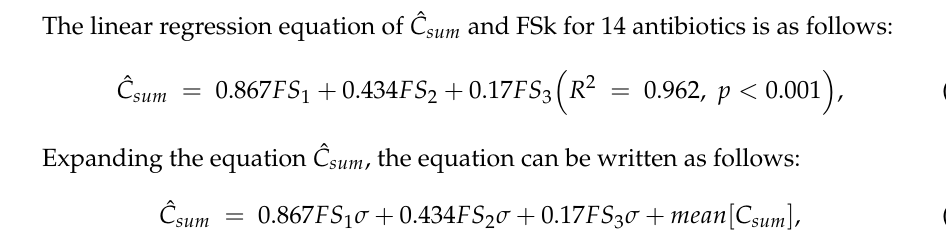
Figure 5. Distribution map of antibiotic contribution rate of HNWP.